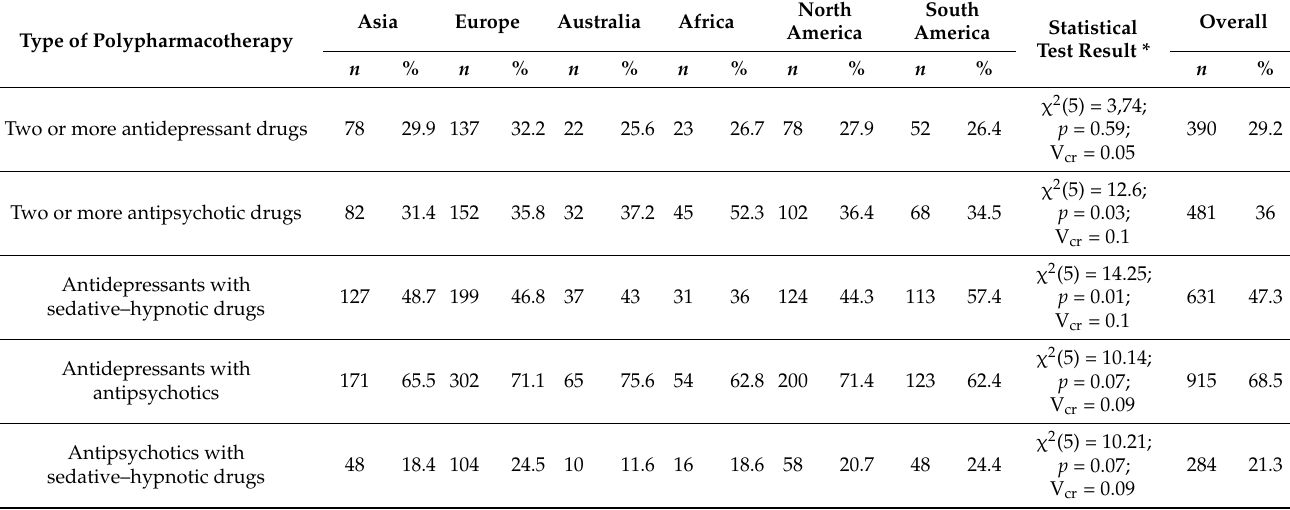
Table 4. Types of polypharmacotherapy used by the surveyed group of